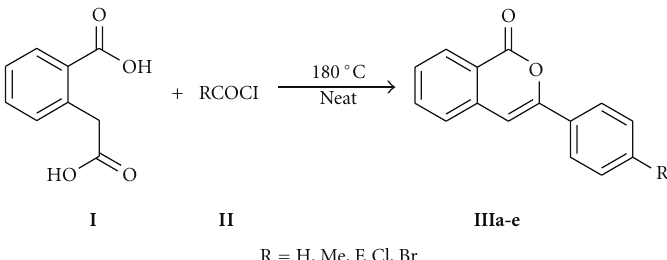
Scheme 1: Synthesis of 3-substituted isocoumarins IIIa-e